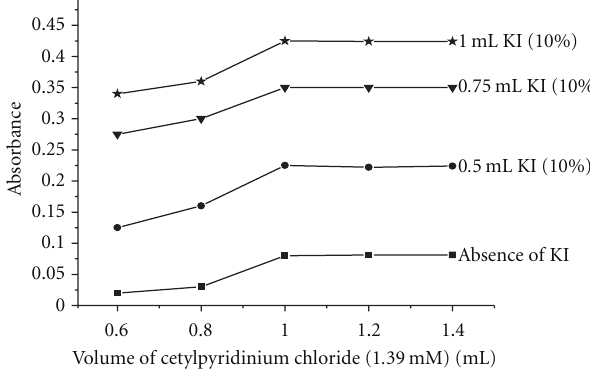
Figure 8: E ff ect of EDTA.